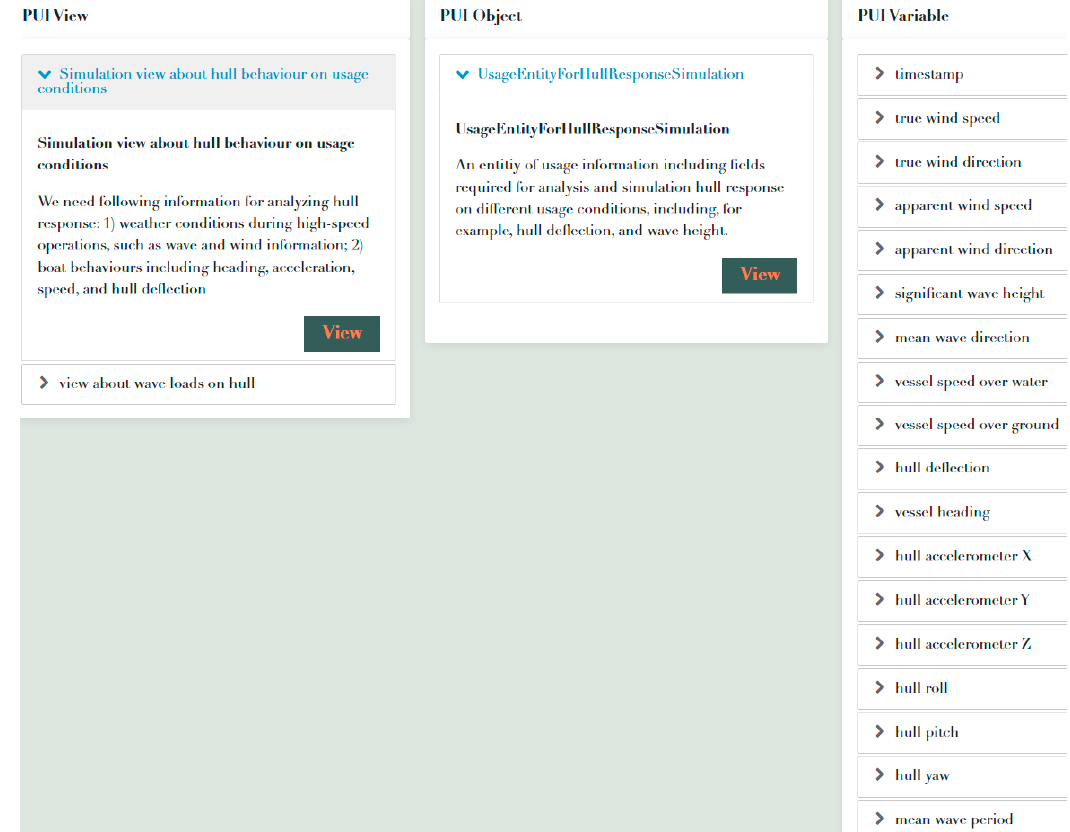
Figure 16. Information needs addressing the main concern of the task.